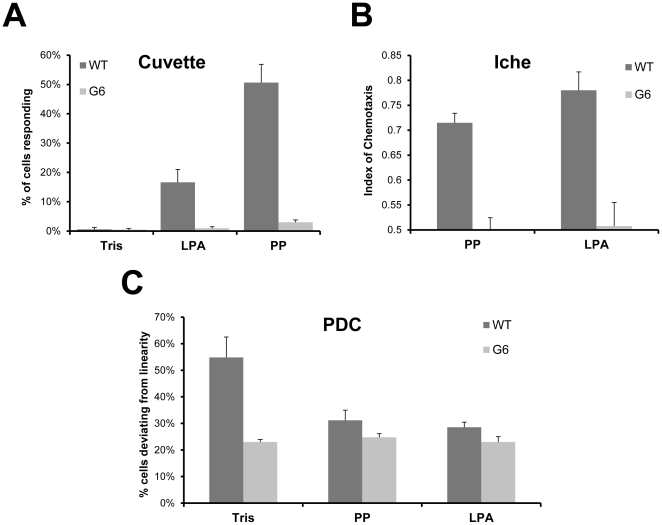
Chemoattraction behavior is altered in the G6 knockout cell line.
A. The chemoattraction assay commonly used in Tetrahymena (two-phase assay) showed that proteose peptone (PP, 1 mg/ml) and lysophosphatidic acid (LPA, 10 µM) are chemoattractants for wild-type two-day starved cells. Data represents the % of cells that accumulated in the lower phase after 30 min., n = 3 separate cultures. Chemoattraction responses were not present in the G6 mutant cell line. B. Three-way stop cock assay typically used for ciliate behavior analysis. While wild-type showed chemoattraction to either 1 mg/ml PP or 10 µM LPA, G6 is significantly less than wild-type in both cases. The G6 mutant showed no attraction towards either PP or LPA, n = 5. C. Transfer of cells from the control solution (Tris) to either PP or LPA significantly decreases the percent of directional changes (PDC) in wild-type. A decrease in PDC has been associated with chemoattraction responses in ciliates. The G6 mutant does not show a significant decrease in PDC because the PDC level is already low. n = 3 experiments, ∼30cells each. Significance determined by student t-test<0.05 with bonferroni correction where applicable.